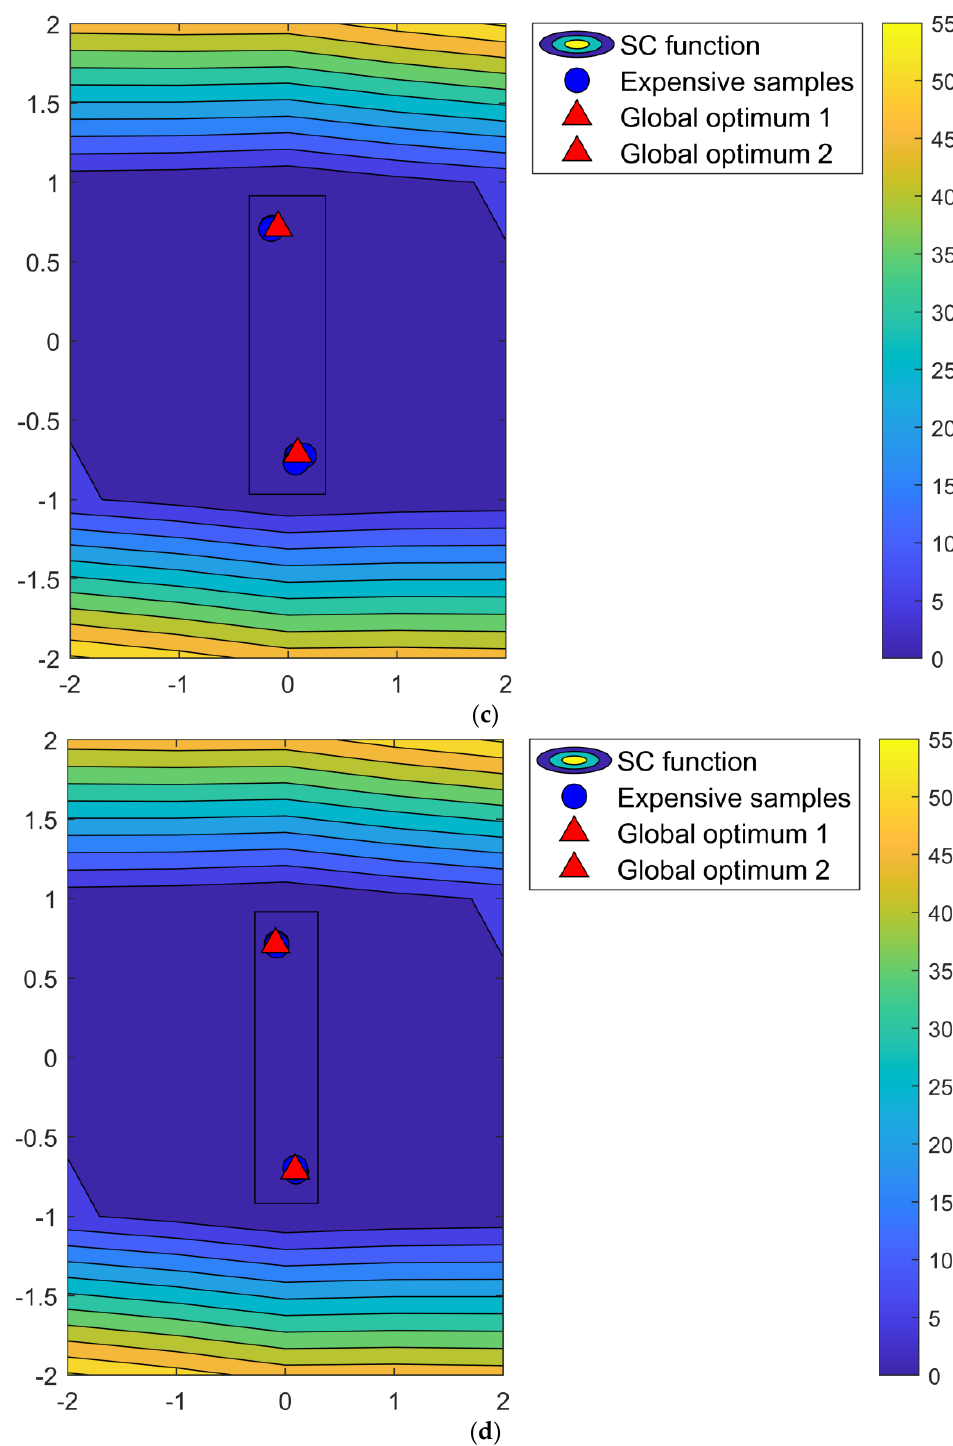
Figure 4. Evolution of the subspace (NIT = 1, 3, 5, 7). ( a ) Subspace when NIT = 1. ( b ) Subspace when NIT = 3. ( c ) Subspace when NIT = 5. ( d ) Subspace when NIT = 7.